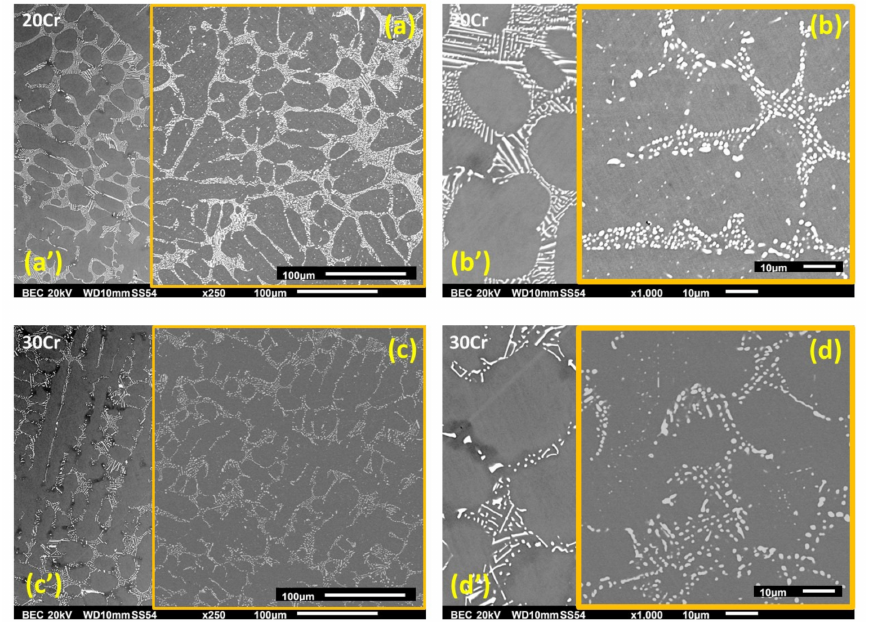
Figure 8. The (1400 K; 96 h)-aged microstructures (framed in orange) of the 20Cr ( a , b ) and 30Cr ( c , d ) alloys; general ( × 250: ( a , c )) and detailed ( × 1000: ( b , d )) views; addition of the as-cast microstruc- tures (20Cr: ( a ’, b ’), 30Cr: ( c ’, d ’)) for